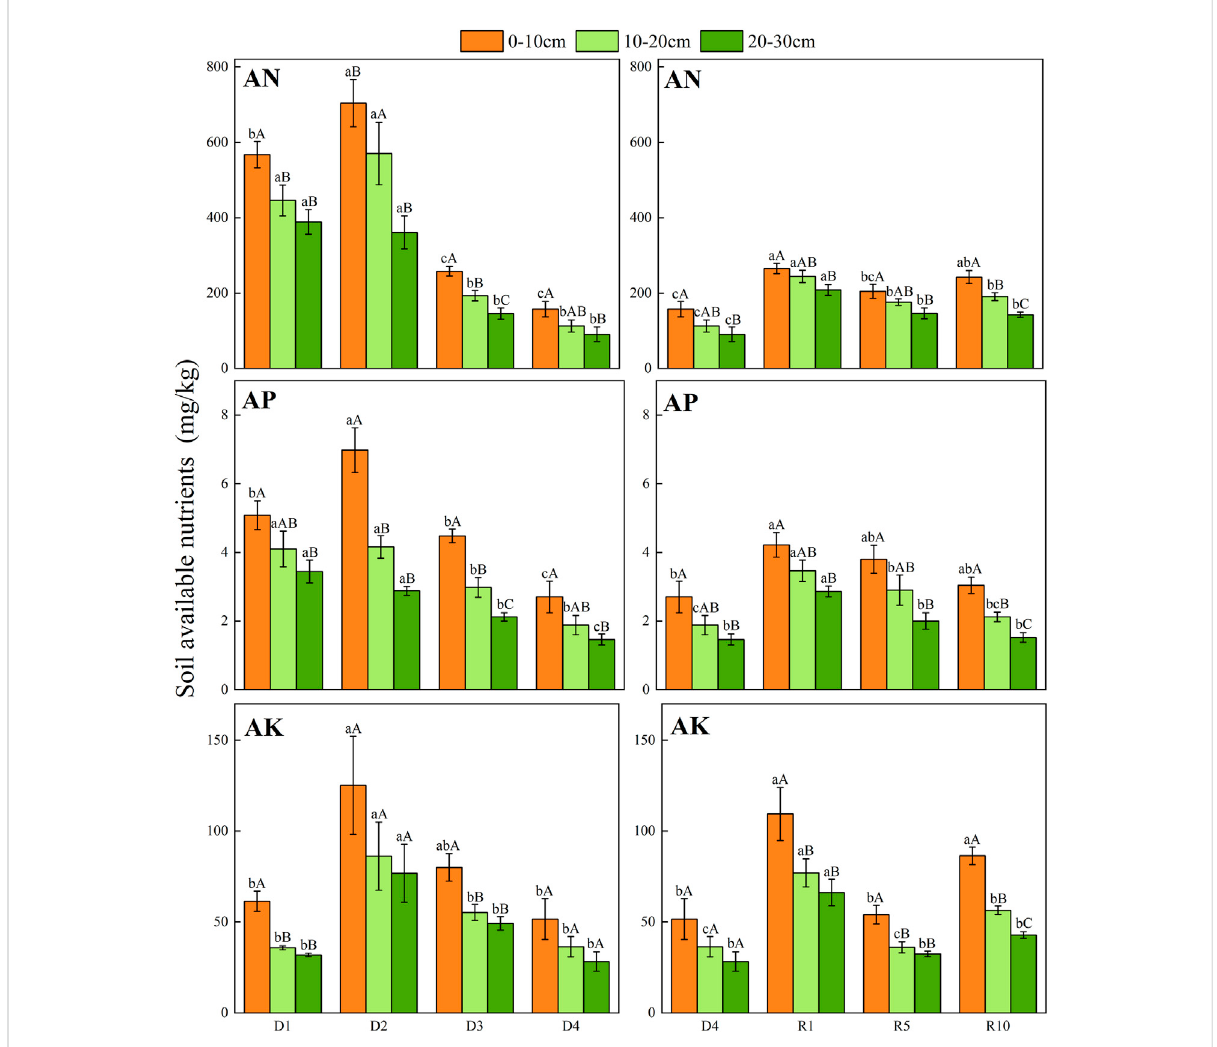
FIGURE 6 Changes in soil available nutrients in different soil layers at different degradation stages and recovery